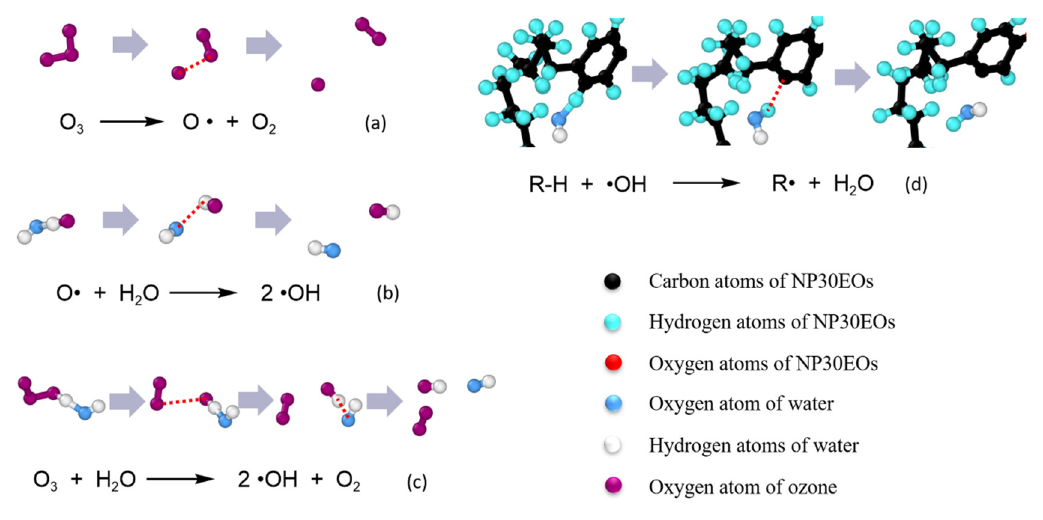
Figure 7. Additional chemical reactions taking place in the ozone nanobubble system. The red dotted line represents the bond to be broken in the given time step.